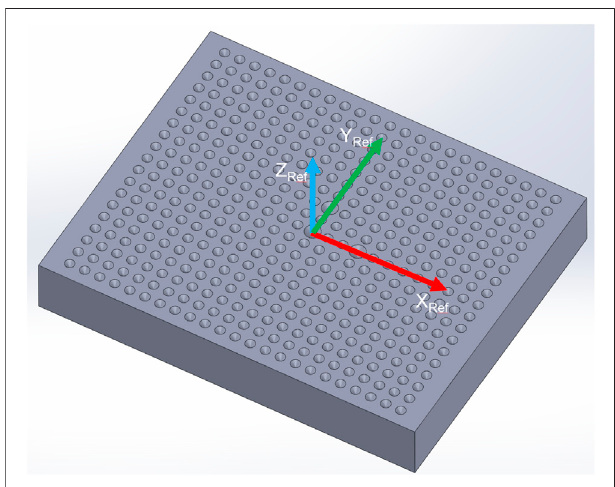
FIGURE 3 | Geometry of the reference plate is composed of a matrix of conical holes where the central three holes determine the pose of the reference coordinate system (XRef, YRef, and